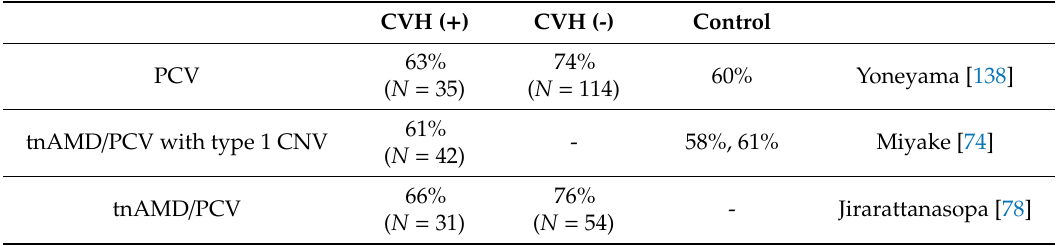
Table 2. Risk allele frequencies of CFH I62V in Japanese patients with age-related macular degeneration. CVH ( + ) CVH (-) Control 63% PCV